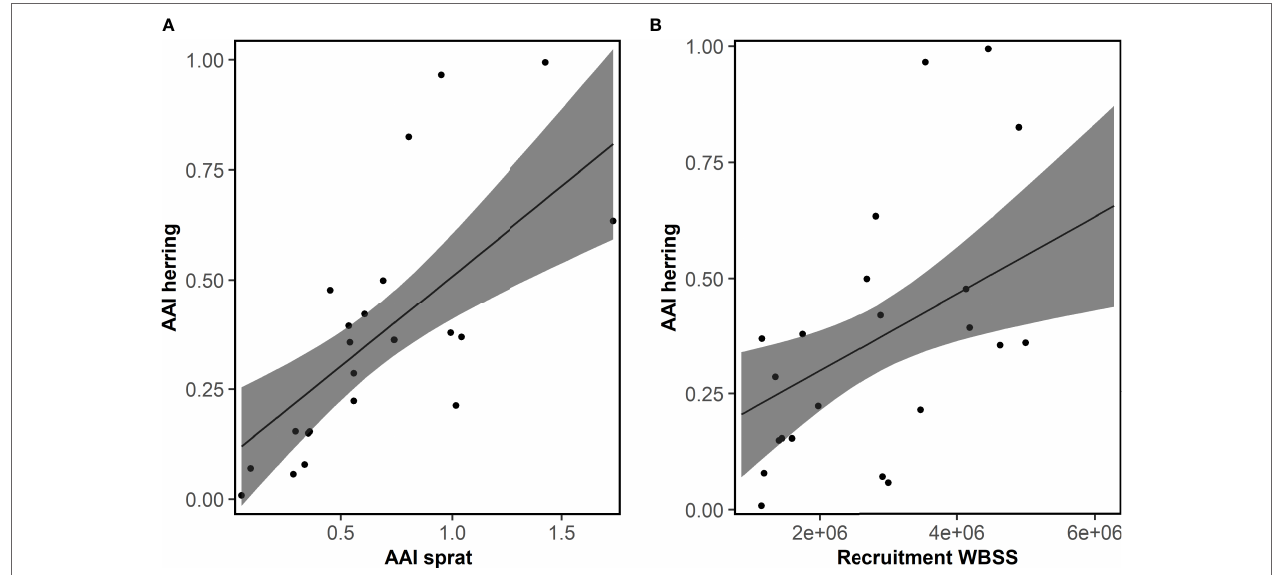
FIGURE 6 | Herring. Fit of the final model explaining the mean annual abundance index (AAI) of 0-group herring for the period 1991-2012 by AAI of sprat and recruitment of western Baltic spring spawning herring (WBSS). Posterior means and 95% confidence intervals for each variable of importance are shown. See Table 2 for model details.